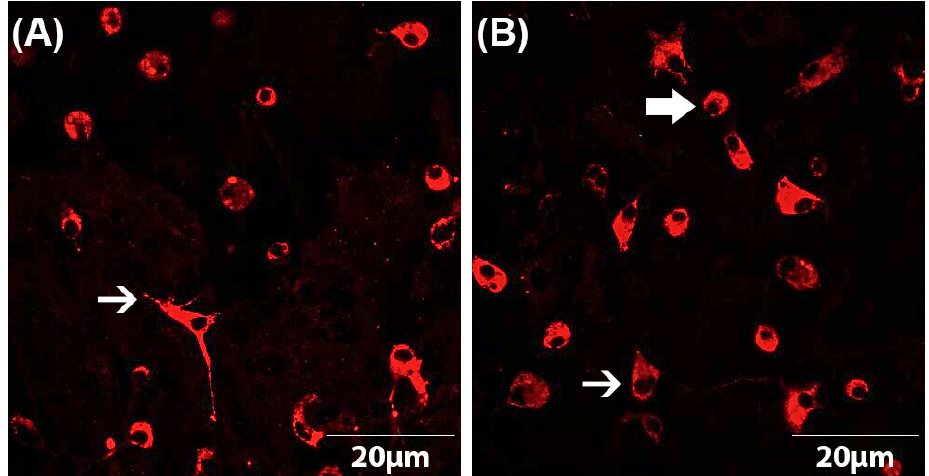
Figure 1. Microglia morphology in astrocyte–microglia co-cultures detected by immunocytochemistry. Staining with the antibody ED-1 (red) allowed the classification of microglia as resting ramified type (RRP) (white arrow in ( A )), intermediate (INT) (thin, white arrow in ( B )) and activated rounded phagocytic type (RPT) (thick, white arrow in ( B )). Fluorescence microscopic images at a magnification of 600×.